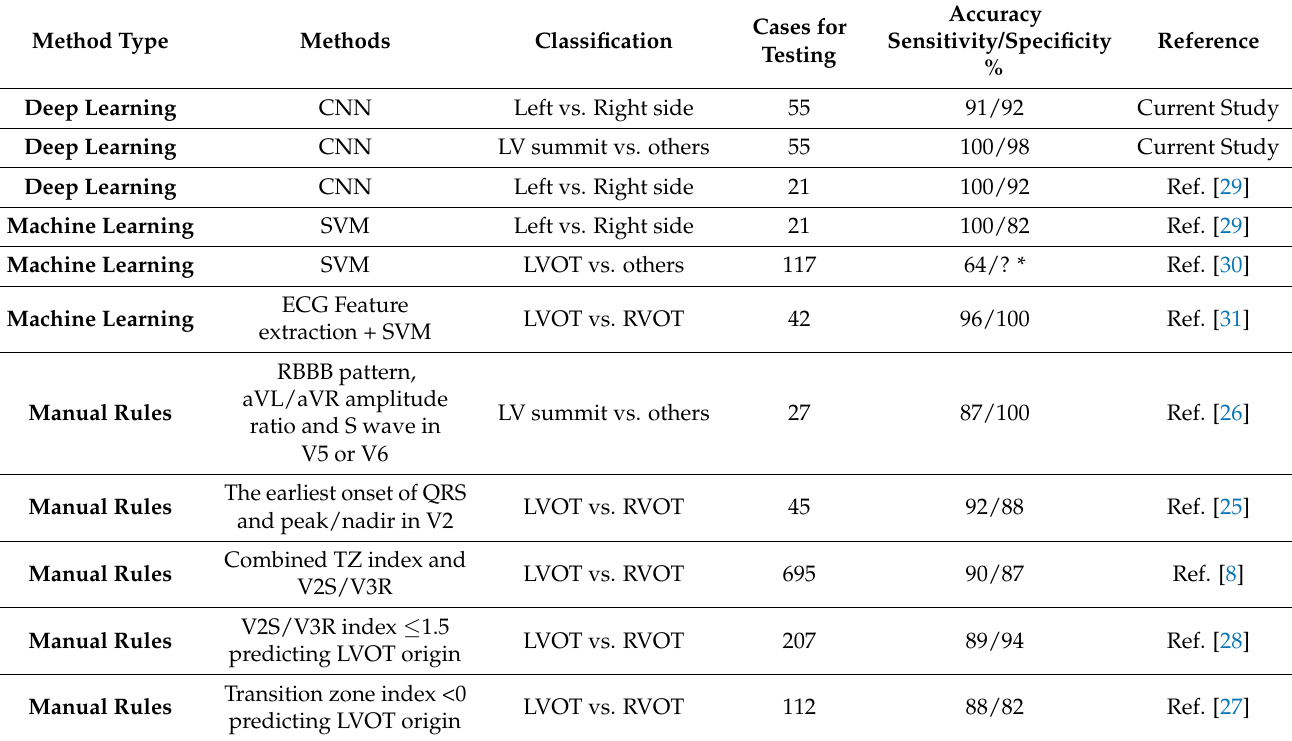
Table 4. Comparison with previous studies for localization of Idiopathic Ventricular